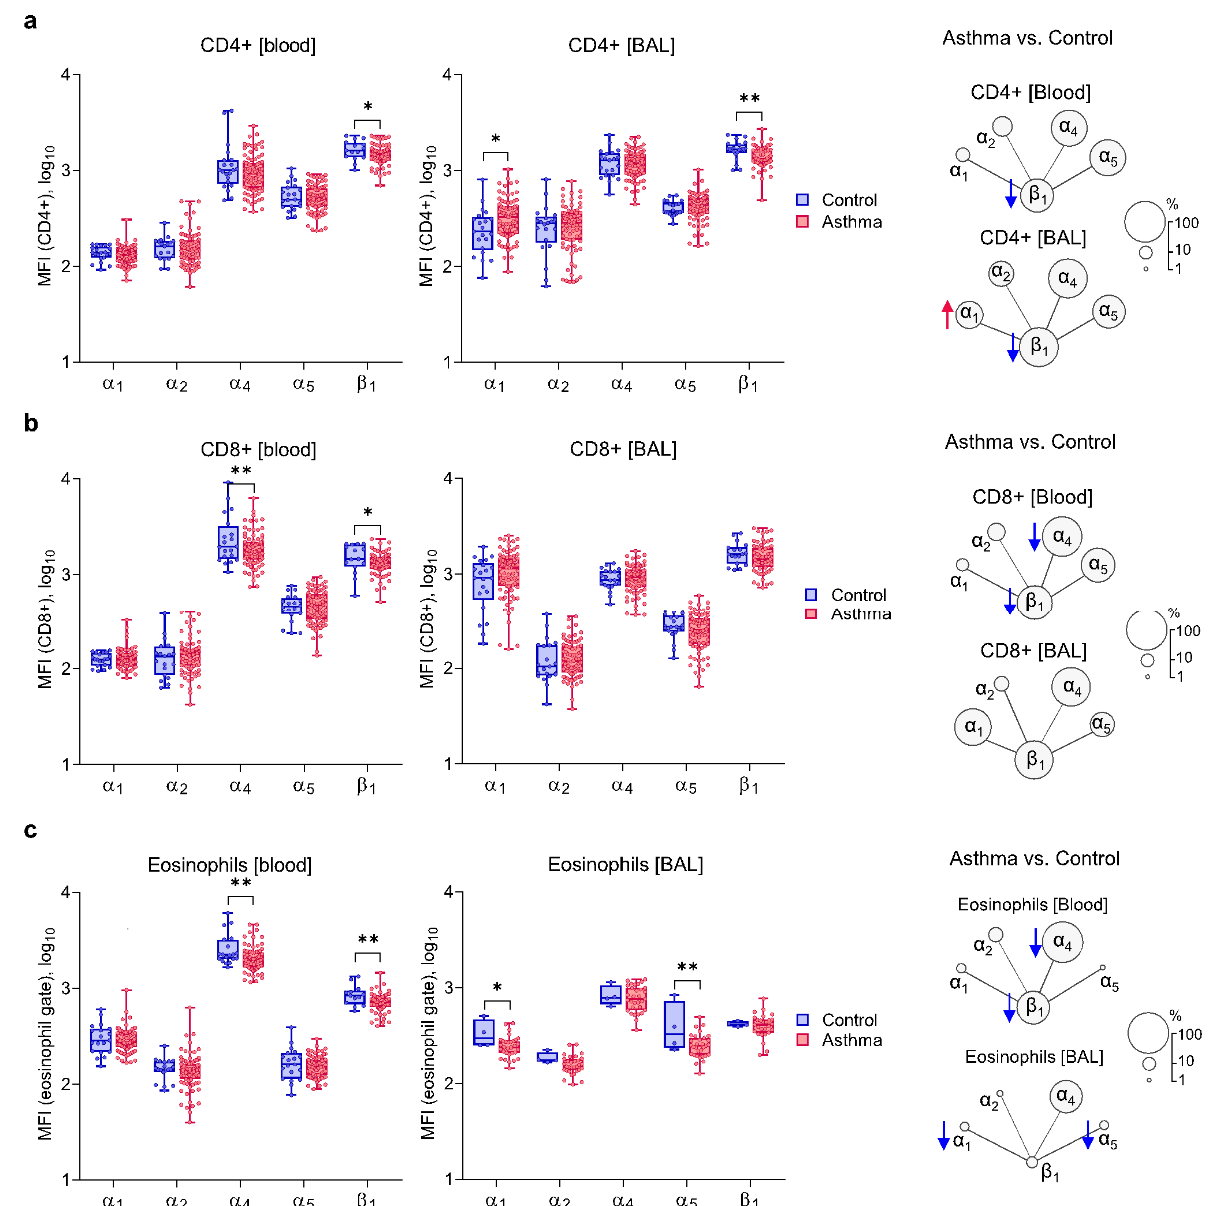
Figure 1. Surface expression of integrin chains on T-cells and eosinophils in asthma and control subjects. Median fluorescent intensities (MFI) of the studied integrin chains in different compartments (on the left) and diagram summarizing the differences in the expression between the two analyzed groups (on the right, circle areas reflect the percentage of cells positive for a given integrin). ( a , b ) Asthma patients showed higher expression of α 1 integrin chain on bronchoalveolar lavage (BAL) CD4 + T-cells (red arrow) and decreased expression of β 1 (blue arrow) on CD4 + blood and BAL and CD8 + blood T-cells and lower expression of α 4 on blood CD4 + T cells. ( c ) Lower expression of surface α 4 and β 1 integrin chains on blood eosinophils and α 1 and α 5 on BAL eosinophils in asthma. Data presented as medians and range (T-cells: blood n = 108, BAL n = 101; eosinophils: blood n = 103, BAL n = 35; β 1 was measured in 78% of samples). Statistics: ANCOVA with adjustment for age, sex, and BMI: * p < 0.05, ** p < 0.01.